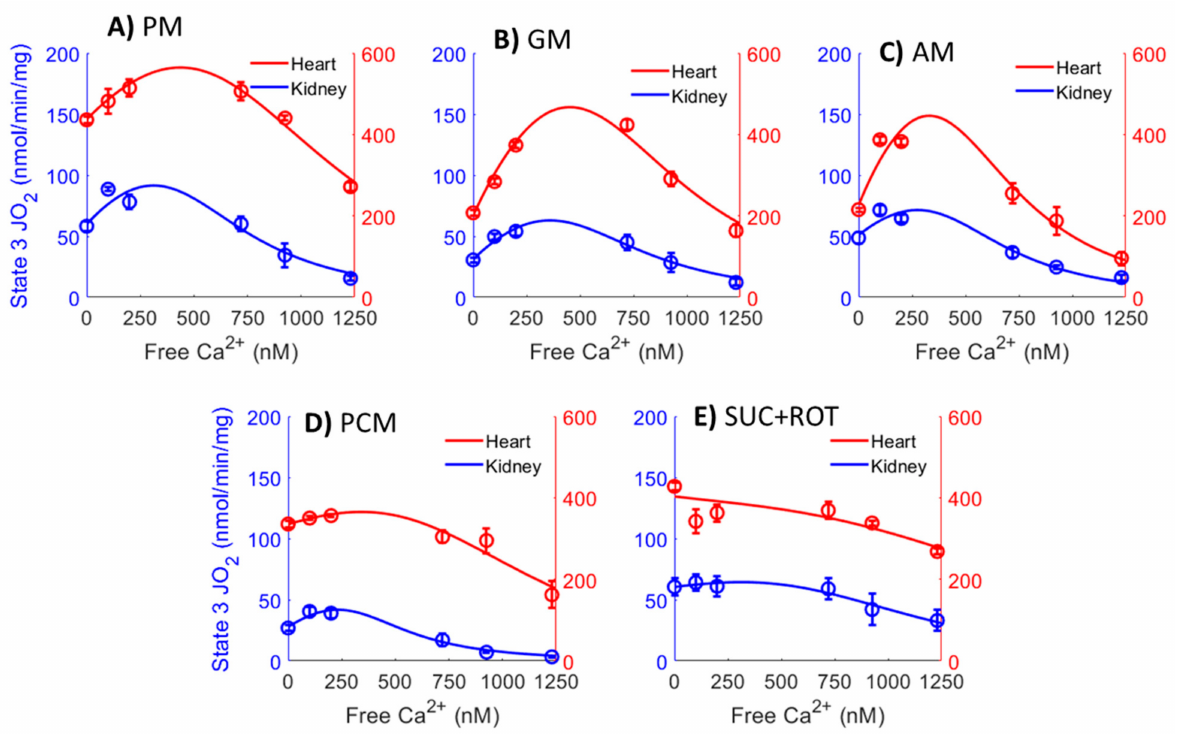
Figure 8. Comparison of the mitochondrial state 3 O 2 consumption rates (OCR; JO 2 ) data between the heart (red points) and kidney OM (blue points) for the different respiratory substrate combinations ( A ) PM, ( B ) GM, ( C ) AM, ( D ) PCM, and ( E ) SUC + ROT) used in the study. Solid lines are the nonlinear regression fits of Equation (1) to the data. The X-axis shows [Ca 2+ ] free in the extra-mitochondrial buffer, which is calculated from the added CaCl 2 ([Ca 2+ ] total ) and 1 mM Ca 2+ chelator EGTA based on Table